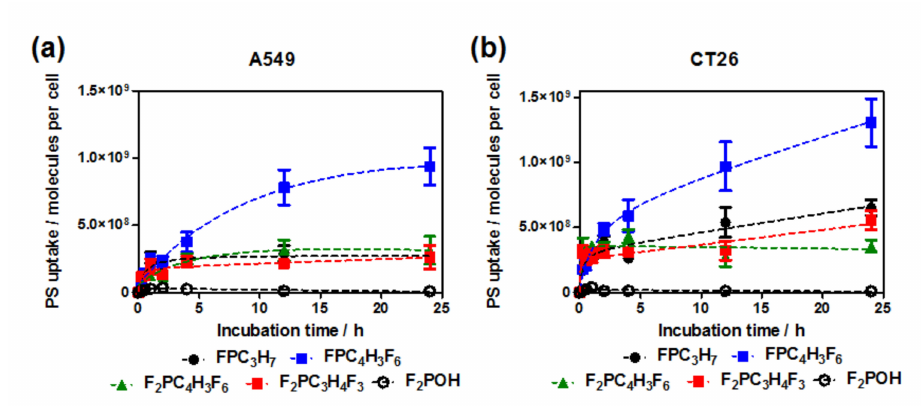
Figure 3. Time-dependent cellular uptake of investigated porphyrins at 20 µ M by ( a ) A549 and ( b ) CT26 cells determined by fluorescence intensity measurements in cellular extracts of each compound.